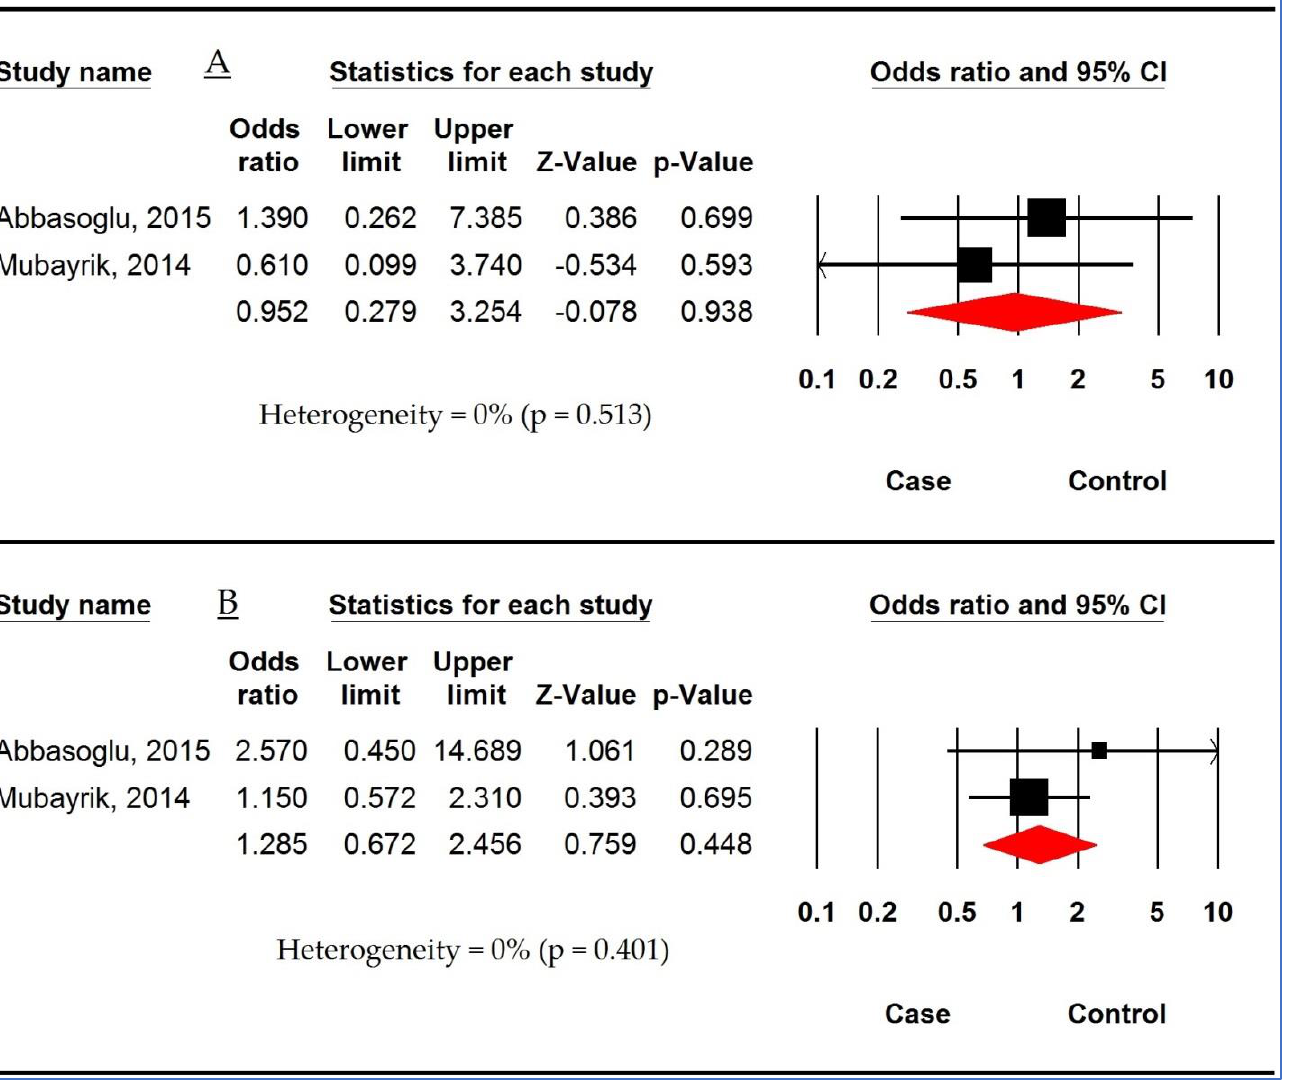
Figure 4. Forest plot for association between defensin beta 1 (DEFB1) rs1800972 polymorphism and dental caries susceptibility. ( A ) Homozygous model. ( B ) Heterozygous model